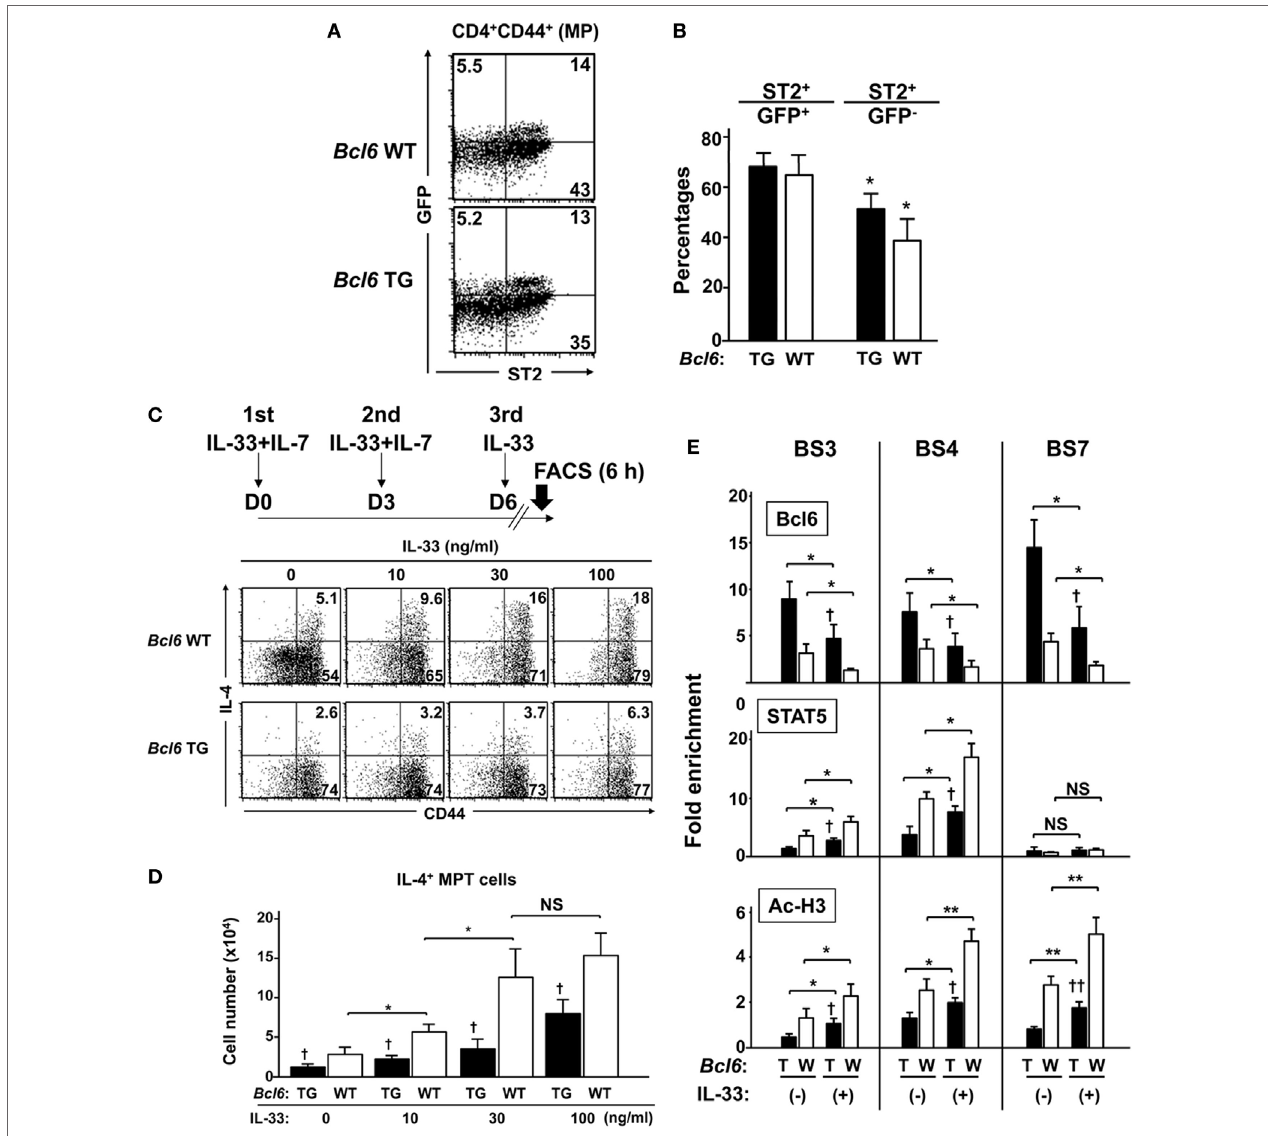
FigUre 9 | IL-33 reinforces IL-4 production by MPT cells through functional competition against the suppressor activity of Bcl6. (a,B) FACS analysis of splenic CNS2-GFP-TG MPT cells from Bcl6- TG and Bcl6- WT mice at rest. (a) Data show the expression of GFP and ST2 gated cells among all CD4 + CD44 + cells (representative of six independent experiments). (B) Percentages of ST2 + cells among GFP + and GFP − MPT cells. (c,D) IL-33 was added to the culture of MPT cells from Bcl6- TG and Bcl6- WT mice three times in the presence of IL-7. [ (c) top] Six hours after the last IL-33 dose, MPT cells were analyzed for intracellular IL-4 levels. Numbers indicate the percentage of IL-4 + cells among all MPT cells. [ (c) bottom] FACS analysis data are representative of four independent experiments. (D) Absolute numbers of IL-4 + MPT cells 8 h after the last IL-33 dose. (e) ChIP analysis of Bcl6 and STAT5 binding and Ac-H3 at each BS in CNS2-GFP + MPT cells from Bcl6- TG (T) and Bcl6- WT mice(W). Cells were primed with or without IL-33 three times in the presence of IL-7. Analysis was performed 8 h after the last IL-33 dose. All results are representative of three (a–D) or four (e) independent experiments with similar outcomes. Data are presented as the mean ± SEM ( n = 6–7) . * P < 0.05, ** P < 0.01, comparison between two groups is indicated ; † P < 0.05, †† P < 0.01, compared with WT. Ac-H3, acetylated histone H3; Bcl6, B-cell lymphoma 6; BS, binding sequence; ChIP, chromatin immunoprecipitation; CNS, conserved noncoding sequence; FACS, fluorescence-activated cell sorting; GFP, green fluorescent protein; MPT cell, memory phenotype CD4 + T cell; TG, transgenic; WT,